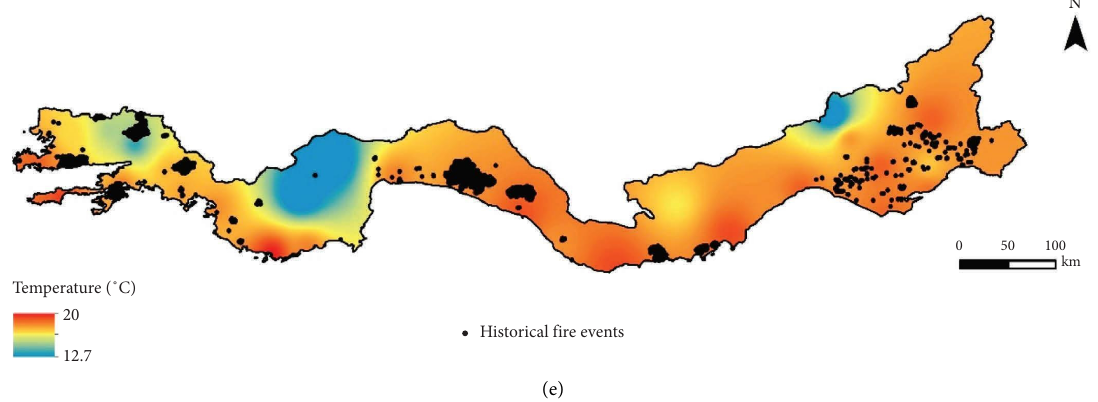
Figure 3: Forest fre conditioning factors: (a) elevation, (b) slope, (c) aspect, (d) TWI, and (e) temperature.